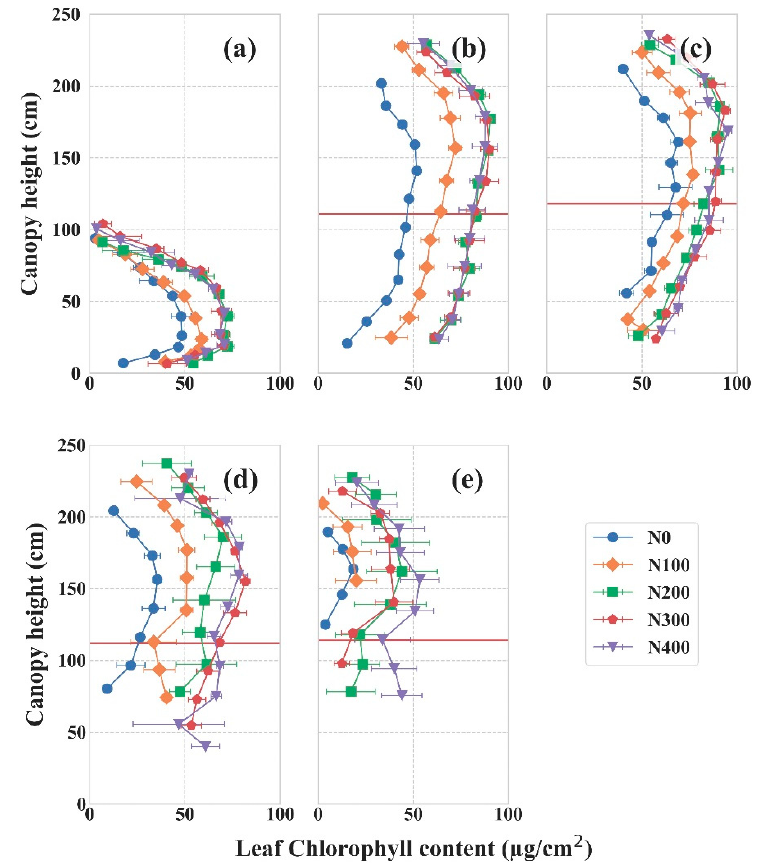
Figure 2. Vertical profile of the leaf chlorophyll content (LCC) within the maize canopy during the 2020 growing season. The y-axis shows the mean height above the ground for each leaf position at five sampling points: ( a ) ninth-leaf stage (day 38), ( b ) silking stage (day 57), ( c ) blister stage (day 71), ( d ) filling stage (day 87), and ( e ) physiological maturity (day 100). The red line denotes the position of the ear leaf (L12). Error bars show standard deviation.